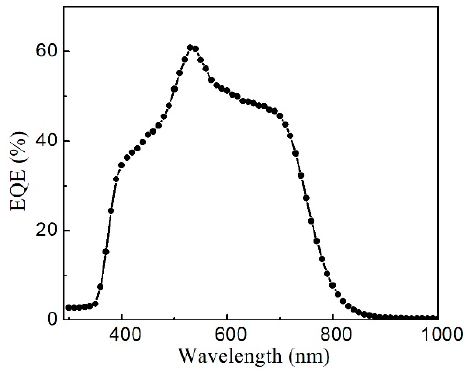
Figure 10. External quantum efficiency (EQE) of CZTS solar cell.